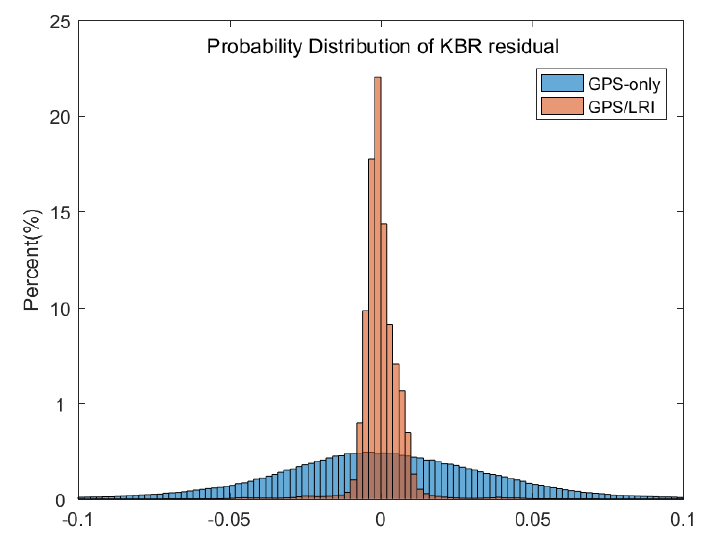
Figure 19. Day 121–242 KBR residuals (unit: m) probability distribution for the GPS/LRI and GPS-only relative orbit.